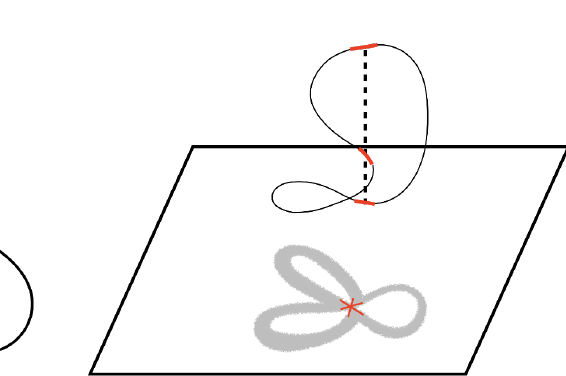
Figure 3 . The normalization of a k = 3 star- crossing